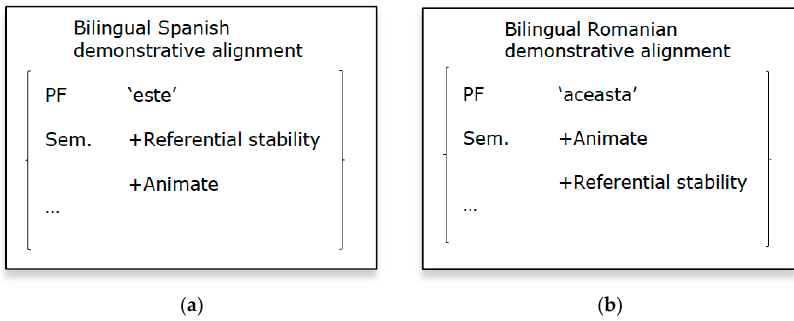
Figure 9. ( a ) Alignment for demonstrative pronouns in bilingual Spanish; ( b ) alignment for demonstrative pronouns in bilingual Romanian.